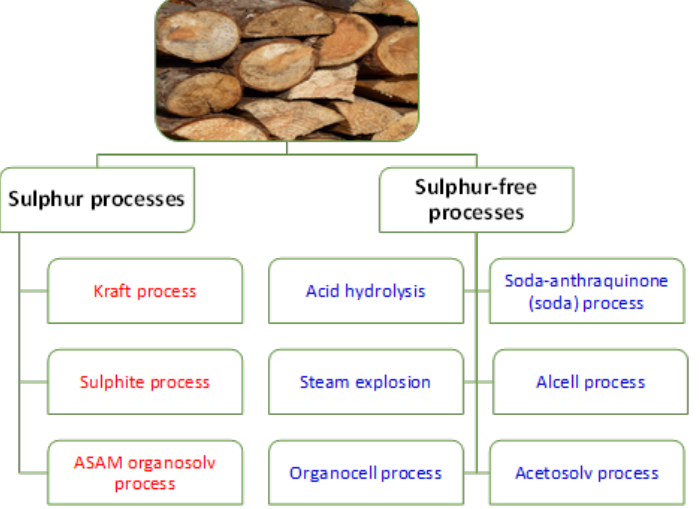
Figure 1. Chemical structures of different lignin monomers: sinapyl alcohol (S), coniferyl alcohol (G), and p-coumaryl alcohol (H) (Adapted with the permission from Ref [3]. Copyright © 2019 Elsevier Ltd.).